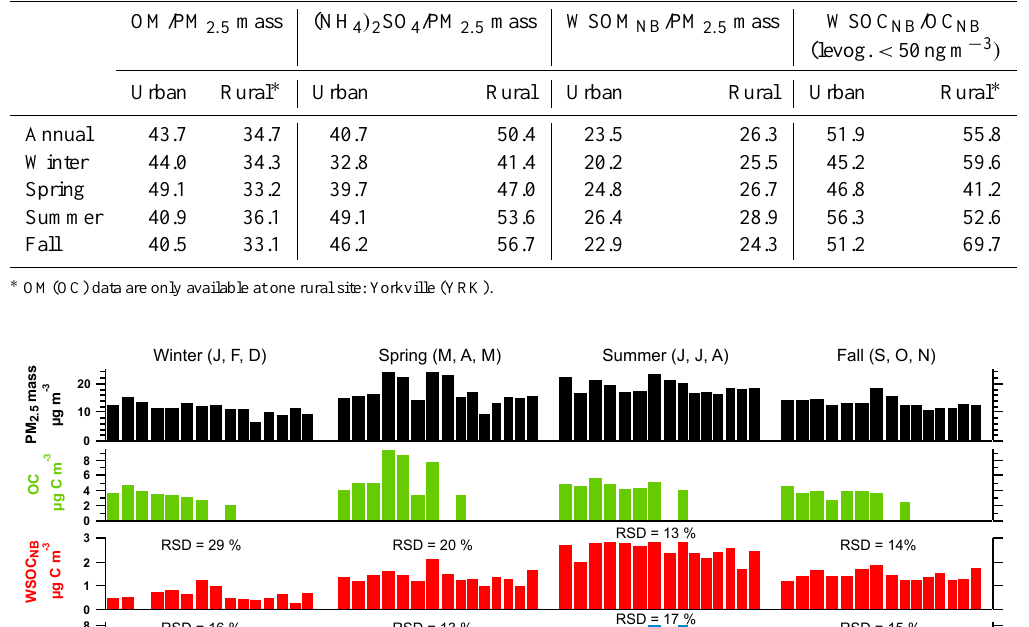
Table 1. Annual and seasonal average WSOC NB /OC NB mass ratios and fractions (%) of organic material (OM), ammonium sulfate, and water-soluble organic material (WSOM) in PM 2 . 5 , where OM is 1.6×OC, WSOM is 2.0×WSOC, and the subscript NB represents non- biomass-burning, using levoglucosan concentration (less than 50ngm − 3 ) as a criteria.